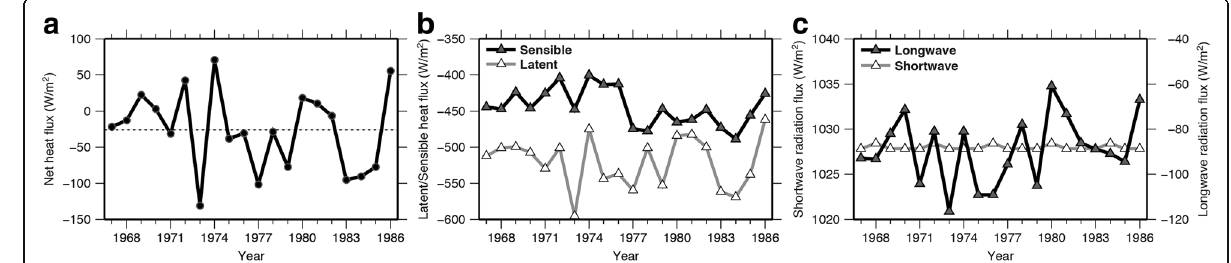
Fig. 16 Simulated time series of heat flux for 1967 to 1986 of the historical simulation. Values are averaged from October to April for a net heat flux, b sensible heat flux (black line with closed triangles) and the latent heat flux (gray line with open triangles), and c longwave radiation flux (black line with closed triangles) and short-wave radiation flux (gray line with open triangles) averaged from October to April. The values from October to December are grouped with the following year. Broken line in a represents the net heat flux averaged over 1967 to